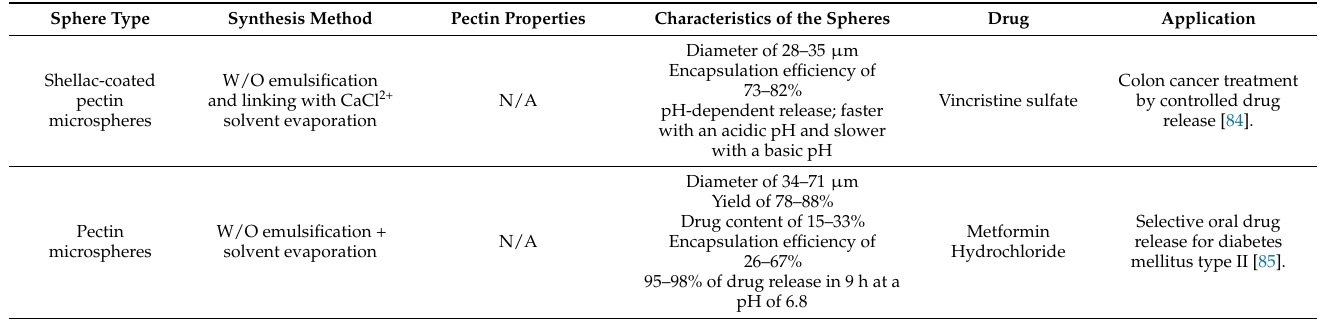
Table 1. Characteristics of synthesized pectin microspheres for drug delivery